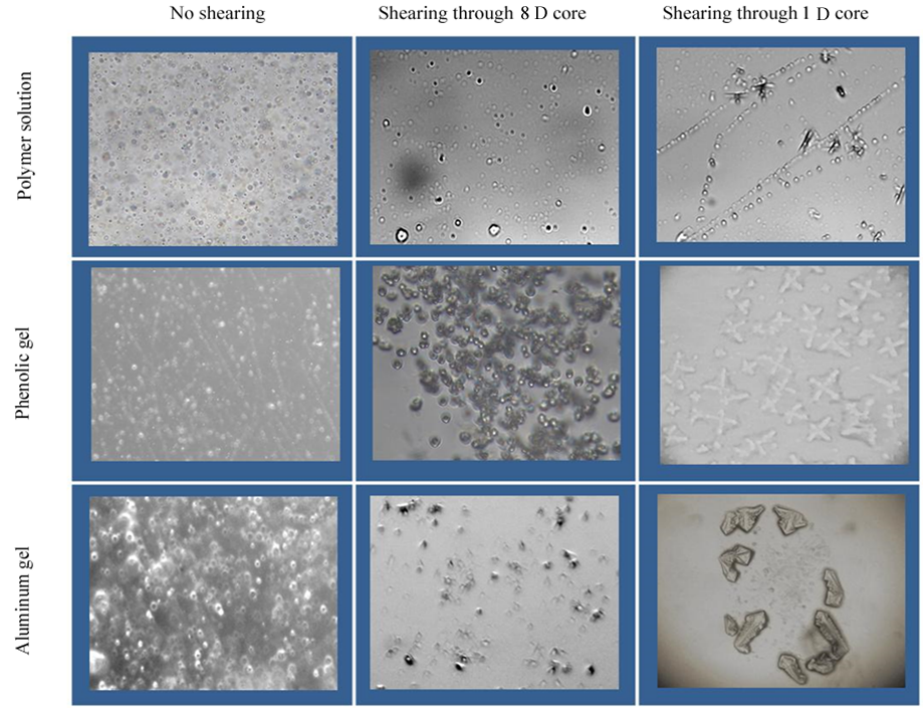
Figure 6. Changes of microscopic aggregation morphology in water solution of polymer and gels after flowing through cores with different permeabilities (×200).